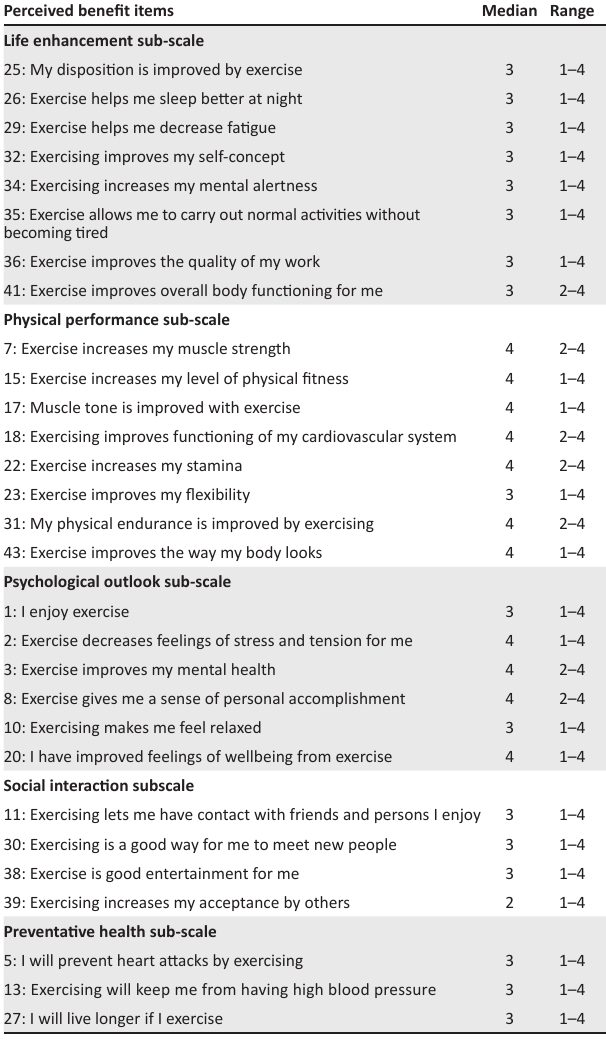
TABLE 2: The exercise benefits scale: Median and range of each questionnaire item.